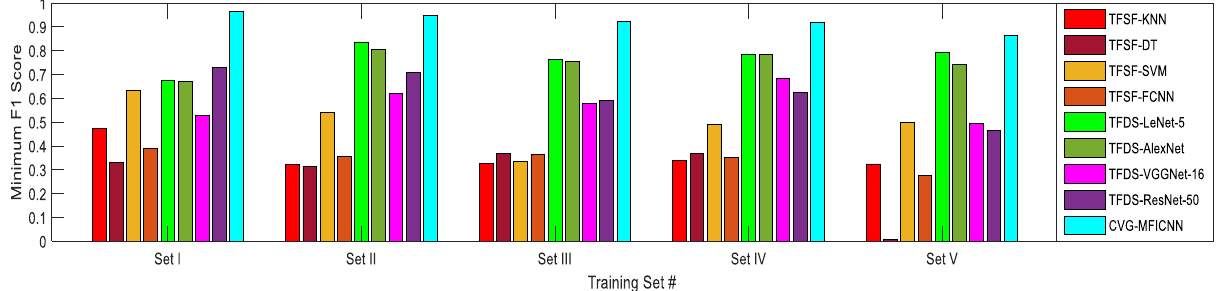
Figure 17. Comparison of minimum testing F1 scores of models trained using the proposed CVG- MFICNN method and existing methods based on different training sets.